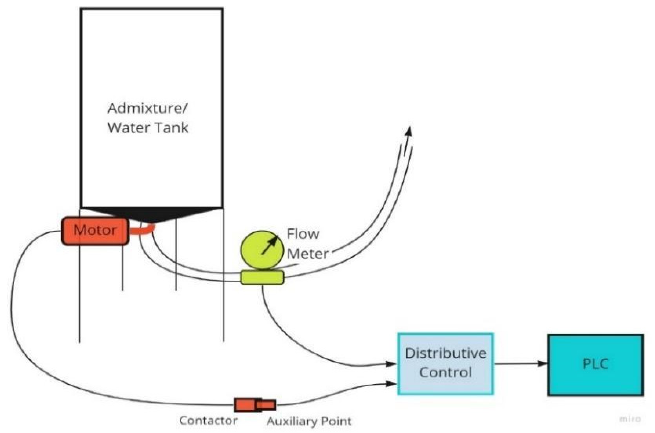
Figure 10. Admixture/Water Pumping Process.